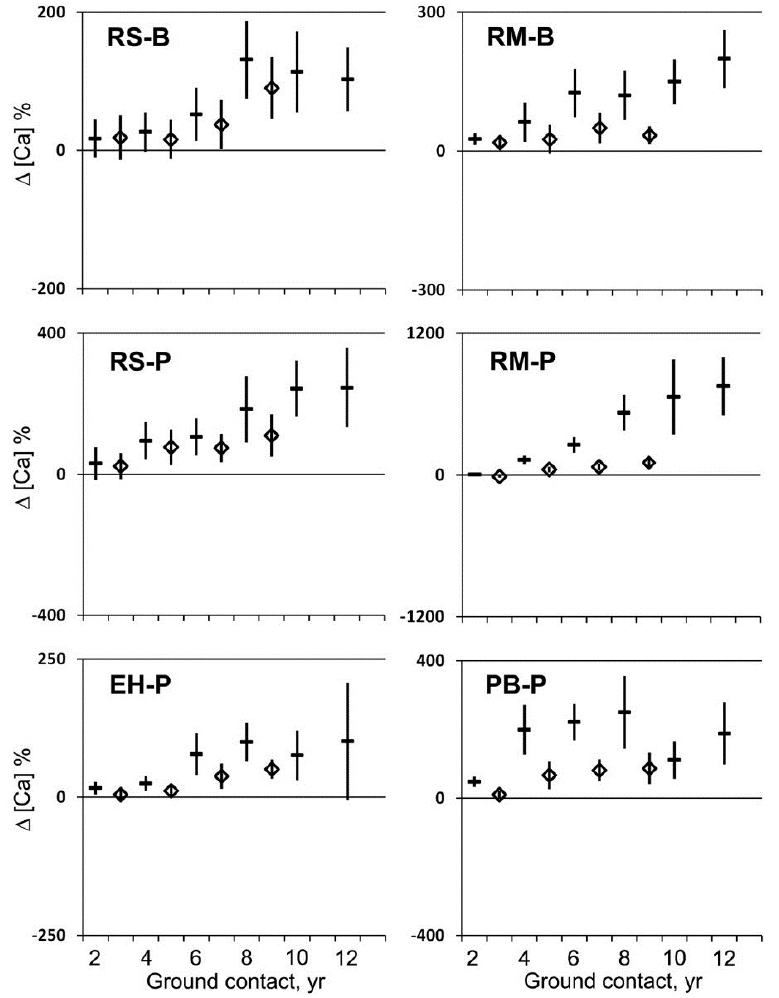
Figure 3. Mean change in calcium concentration per unit mass (dash) and per unit volume (diamond) and 95% confidence interval ( n = 20) for red spruce (RS), eastern hemlock (EH), red maple (RM), and paper birch (PB) at the Bartlett Experimental Forest (B) or the Penobscot Experimental Forest (P) during two to 12 years of decay with ground